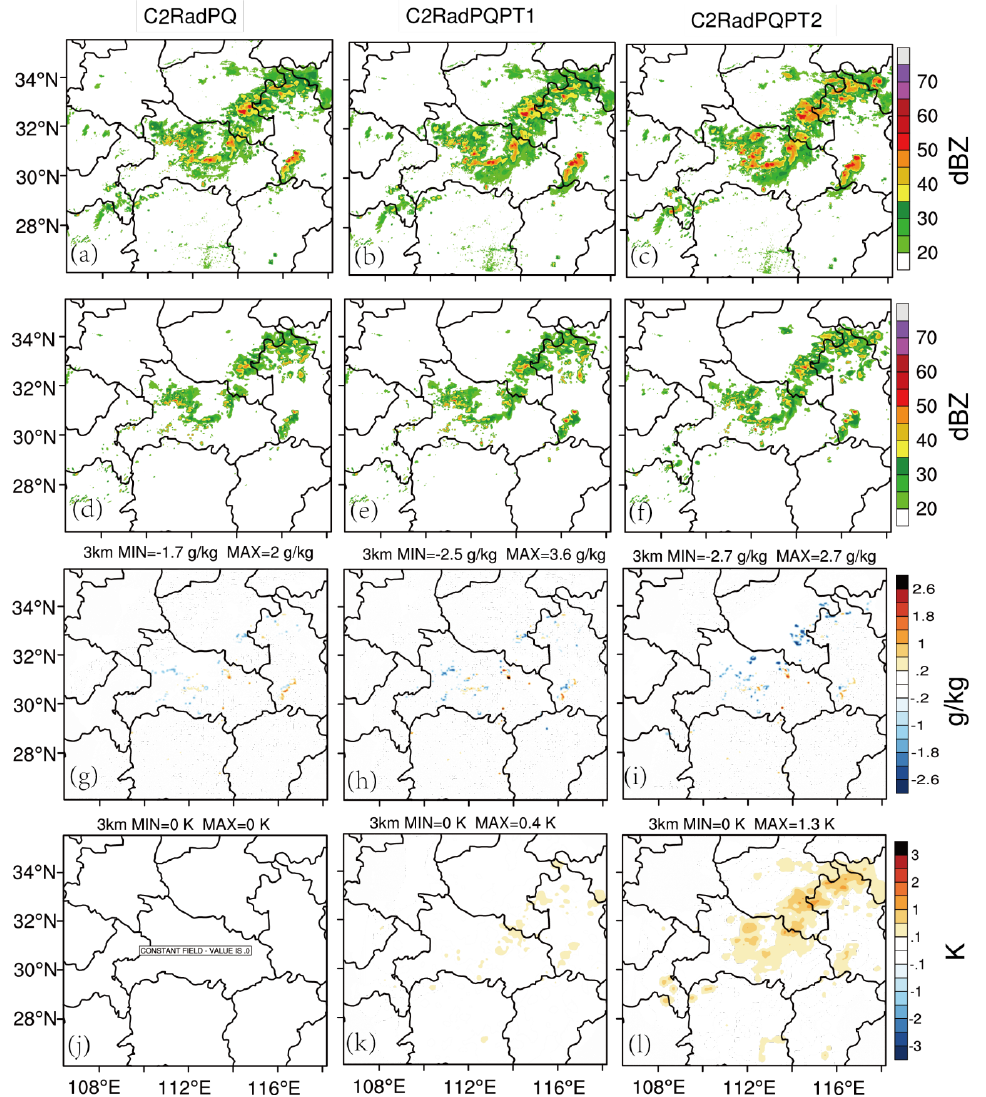
Figure 11. Same as in Figure 5, but for 1400 UTC (4 July, 2018).